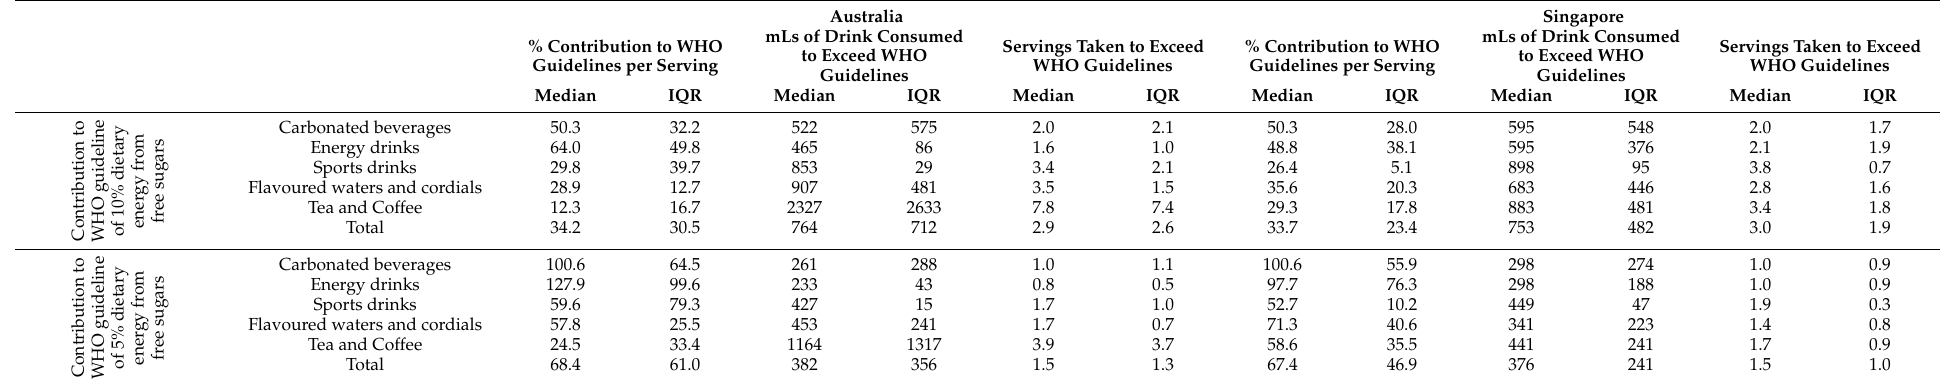
Table 4. Sugar per serving of calorically sweetened beverages in Australia and Singapore and their contributions to meeting/exceeding daily energy intakes from free sugars according to the World Health Organization